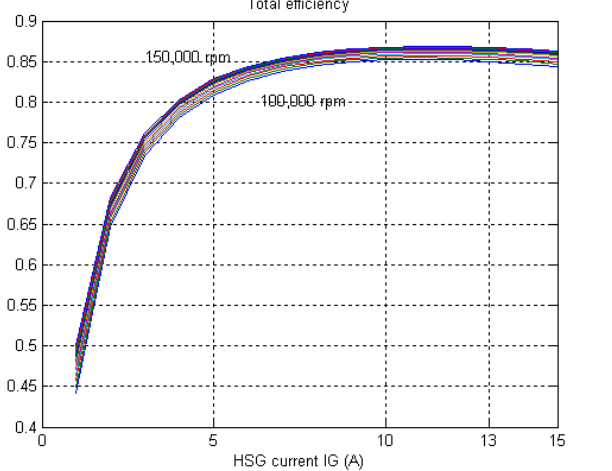
Figure 12. ( a ) Comparison of Power flows (mechanical Power (P0), active Power (P1), rectified Power input to the Electronic Load (P2), and Power injected to the grid (P4)) as a function of generator current IG at different speed levels; ( b ) HSG calculated efficiency as a function of the generator current IG varying the MGT speed from 100 to 150 krpm.